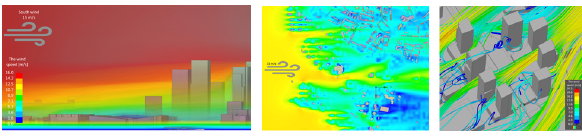
Figure 3. left: View of Kalasatama from the east. A south wind blows 15 meters per second, middle: A section cut of wind speeds about 31 meters above sea level, right: airflow coming from the right edge (south) of the image at a height of about 50 meters (Suomisto et al.,